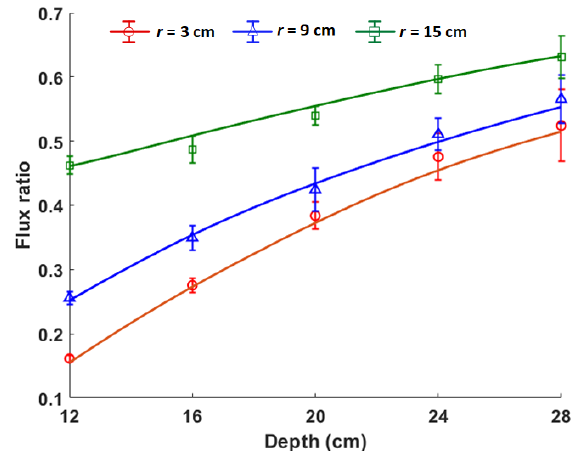
Figure 8. Flux ratio (i.e., F 2 / F 1 ) for sources of radii of 3 cm, 9 cm and 15 cm buried at various depths in dry soil ( ρ b = 1.52 g cm − 3 ). The solid lines are calculated values, while the markers are the values from the simulation.